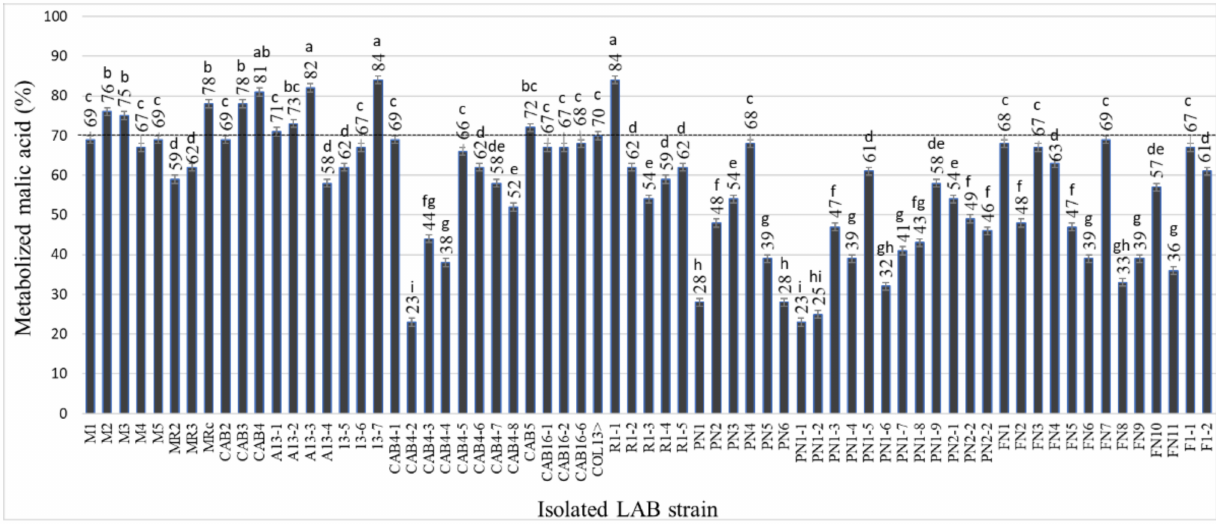
Figure 3. Malic acid bioconversion yield of lactic acid bacteria isolates in synthetic wine (12% v/v ethanol; 3 g/L malic acid) after 20 days. Different letters indicate statistically significant differences between variables. Values with the same letter are not statistically significant ( p >